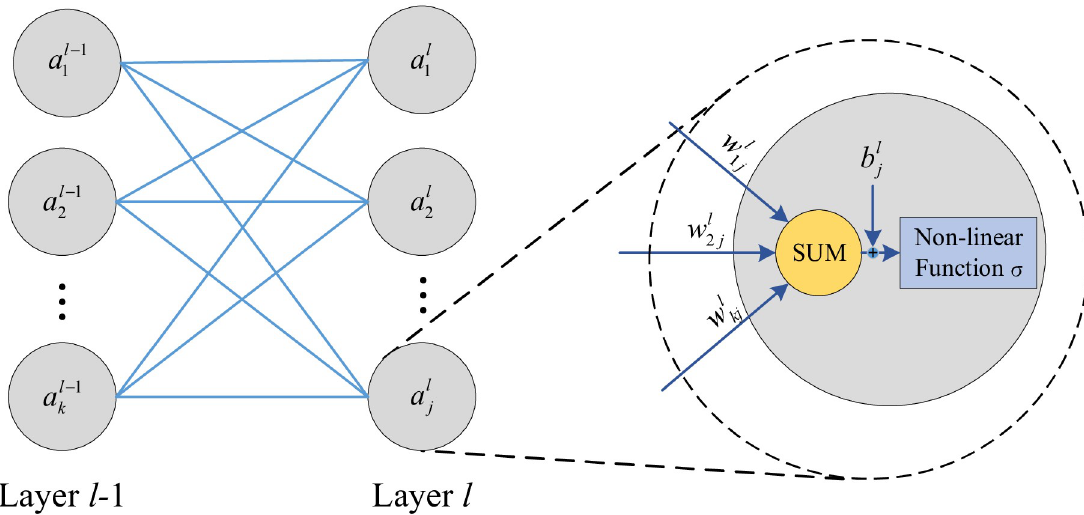
Fig 5. Operation flow chart of adjacent two layers of fully connected neural